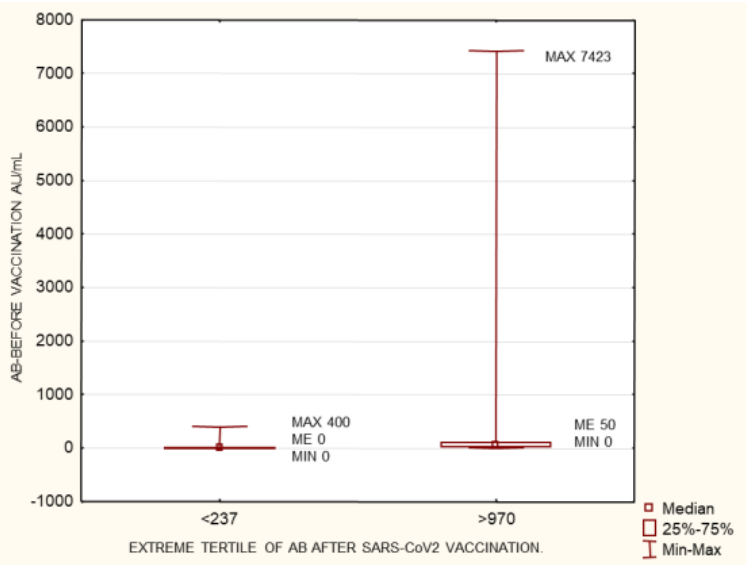
Figure 3. Statistically significant differences in antibody levels against SARS-CoV2 before vaccination between the extreme terciles of AB levels after SARS-CoV-2 vaccination <237 AU/mL and >970 AU/mL p = 5.26 × 10 –11 . Mann–Whitney U test. AB: antibody. Since a history of SARS-CoV-2 infection prior to vaccination was a factor affecting cellu- lar and humoral immunity after vaccination, patients who had a negative anti-SARS-CoV-2 antibody result prior to vaccination were analyzed ( n = 237). The group was divided into two subgroups depending on the antibody median: group 1 with an AB < 570 AU/mL and group 2 with an AB ≥ 570 AU/mL. Significant differences were found between these groups with regard to the degree of cellular immunity and age (Table